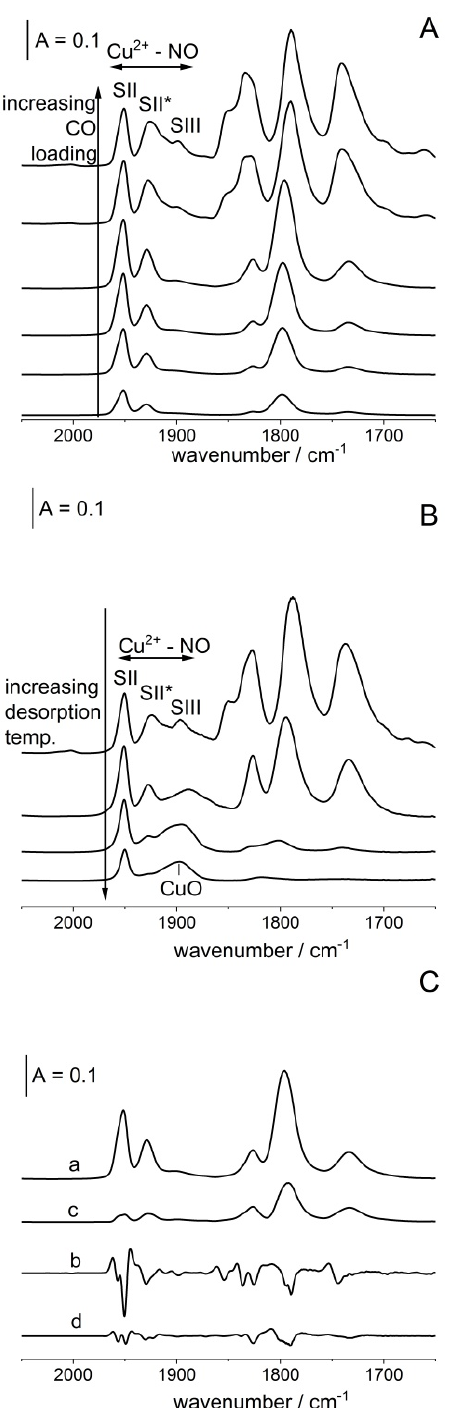
Figure 1. ( A ) The spectra recorded upon the sorption of increasing amounts of NO at ca. 170 K in zeolite CuY. ( B ) The spectra recorded upon the desorption of NO from CuY at vacuum in the temperature range 170–240 K. ( C ) a—the spectrum recorded upon the sorption of 10th dose of NO; b—the difference between the spectra recorded upon the sorption of 5th and 4th NO dose; c,d—the second derivatives of the spectra a and b, respectively.